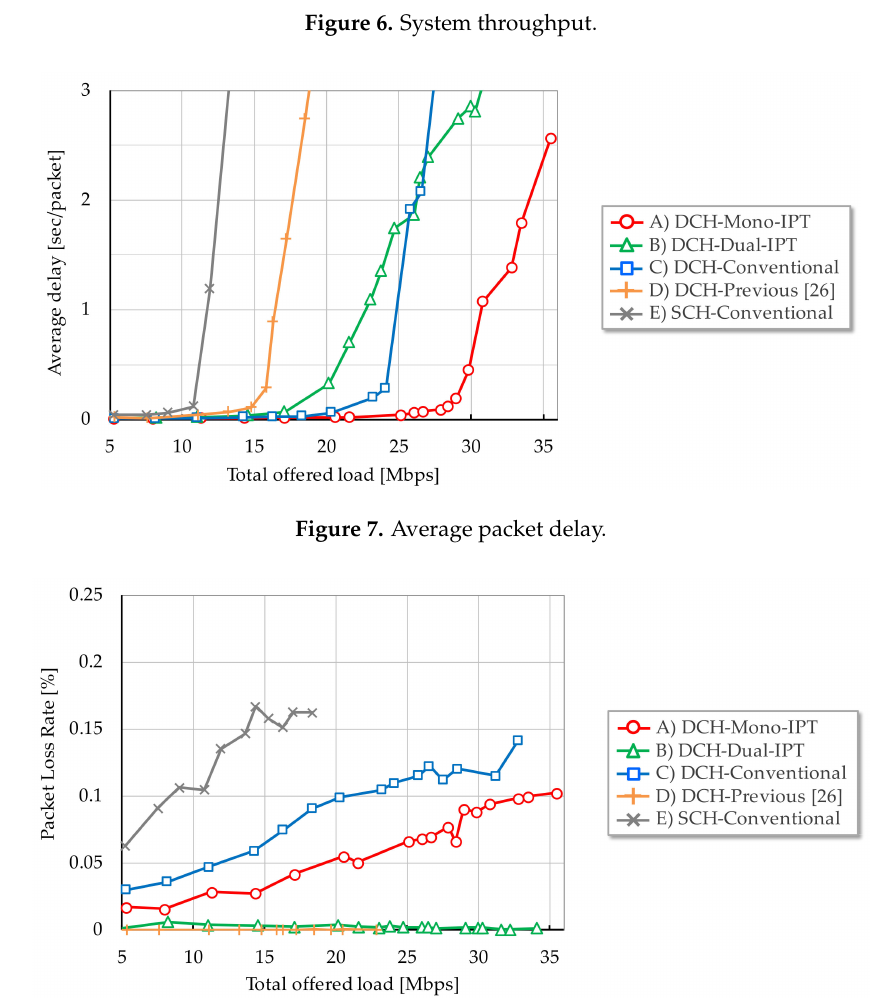
Figure 8. Packet loss